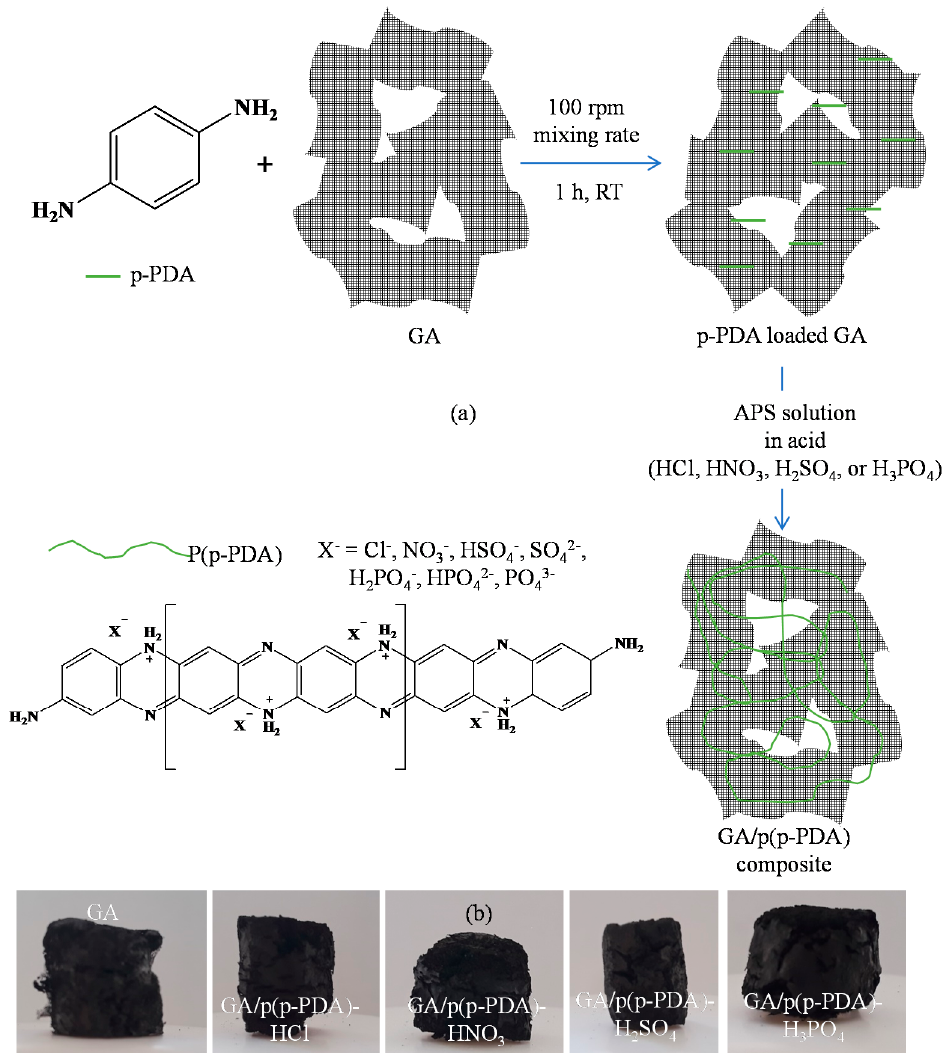
Figure 1. ( a ) Schematic illustration of GA/p(p-PDA) composite synthesis, and ( b ) digital camera images of GA/p(p-PDA) composites.